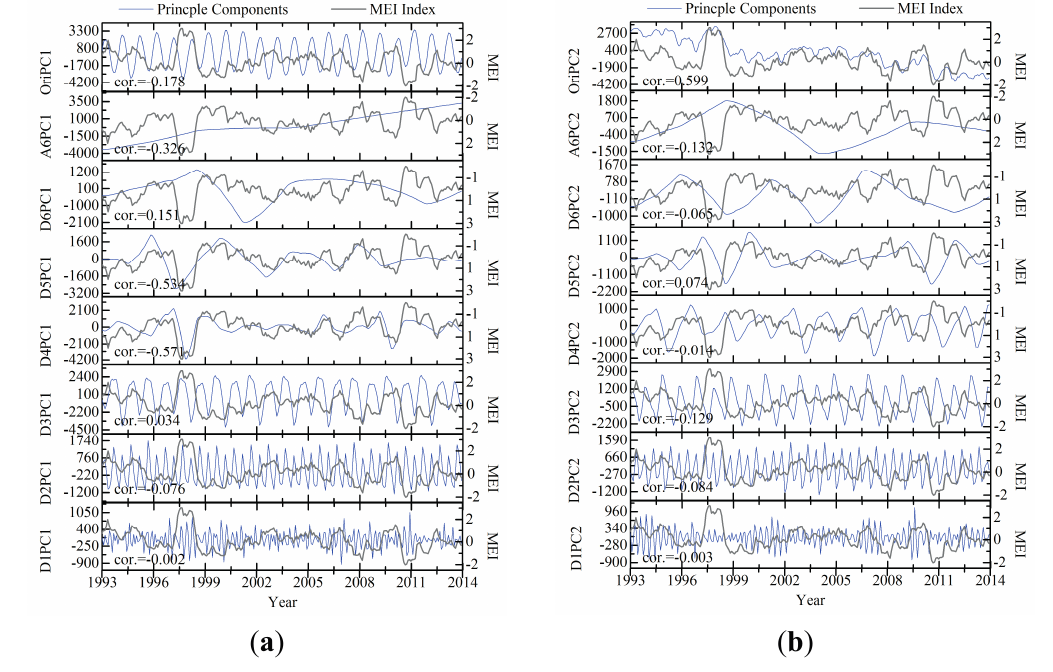
Figure 8. The comparison between the principle components of the decomposed components and the MEI index: ( a ) comparison between the first principle components of the decomposed components and the MEI index; and ( b ) comparison between the second principle components of the decomposed components and the MEI